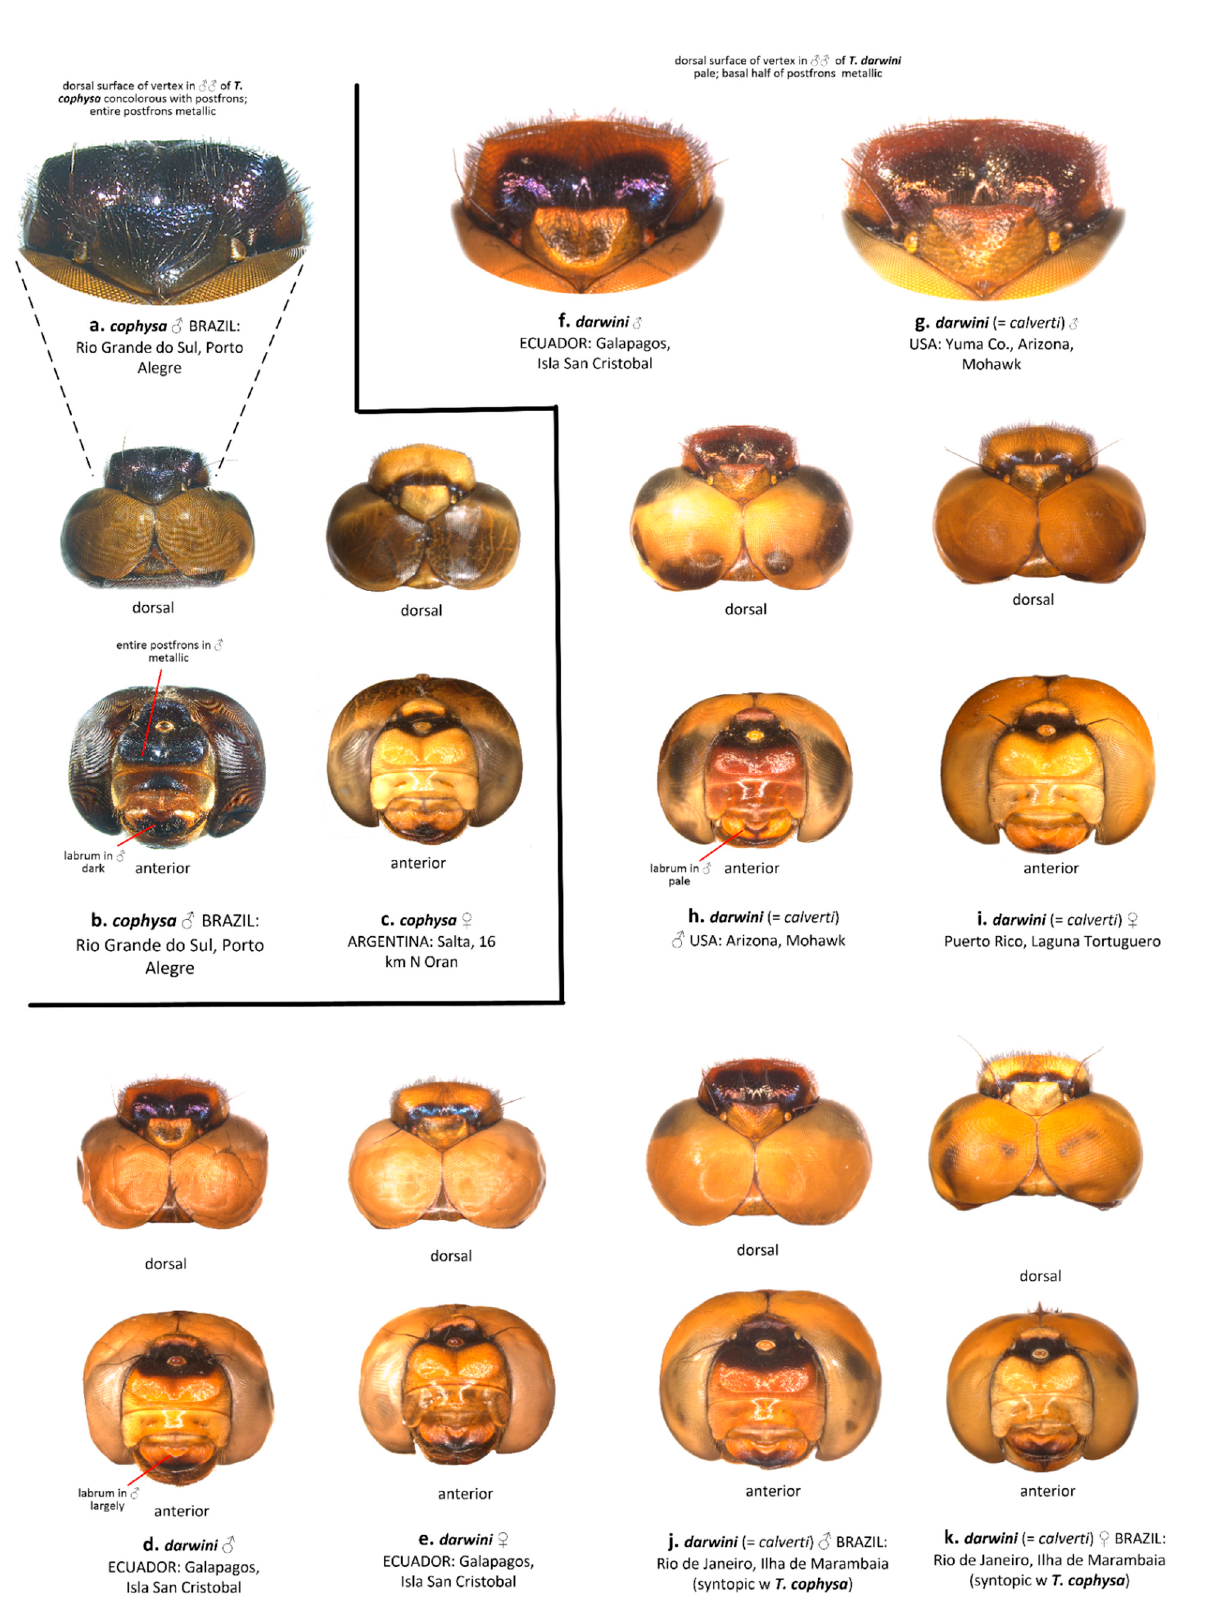
Figure 3. Dorsal and anterior view of the head of males and females of T. cophysa ( a – c ) and T. darwini (senior synonym of T. calverti , stat. rev.) ( d – k ), showing the differences in coloration of vertex, postfrons and labrum.